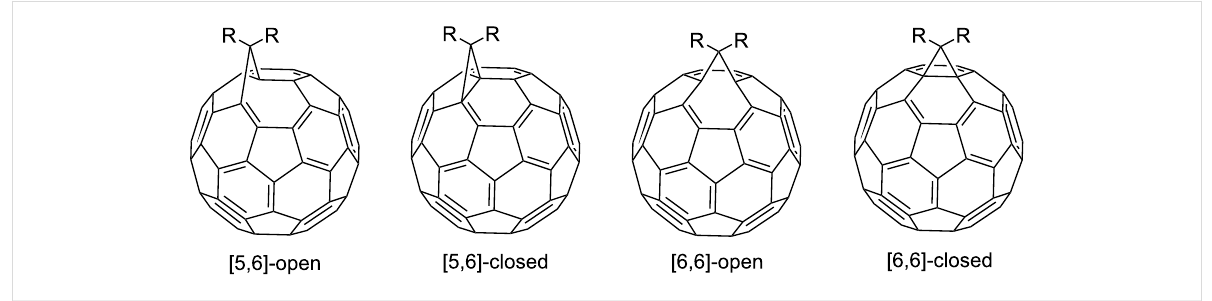
Scheme 1: Methods for the synthesis of methanofullerenes C 60 .